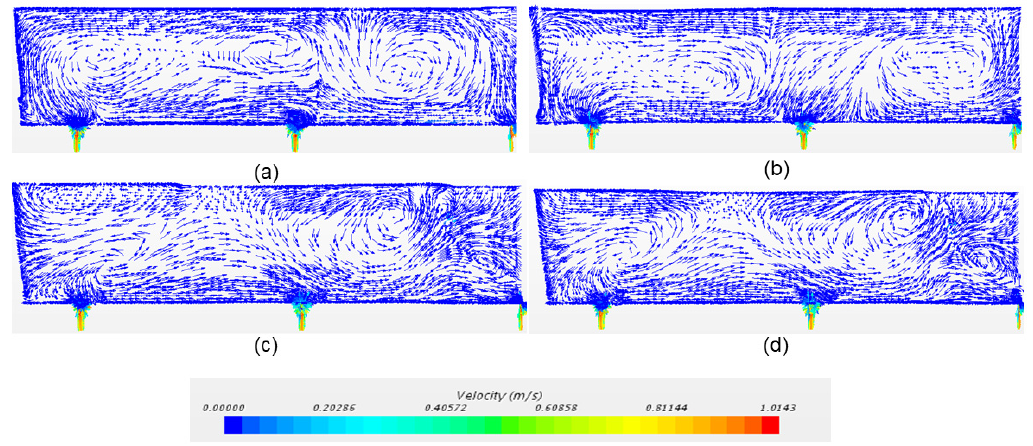
Figure 9. View C. ( a ) Case 1—bare; ( b ) Case 2—TI; ( c ) Case 3—UB; ( d ) Case 4—UB +